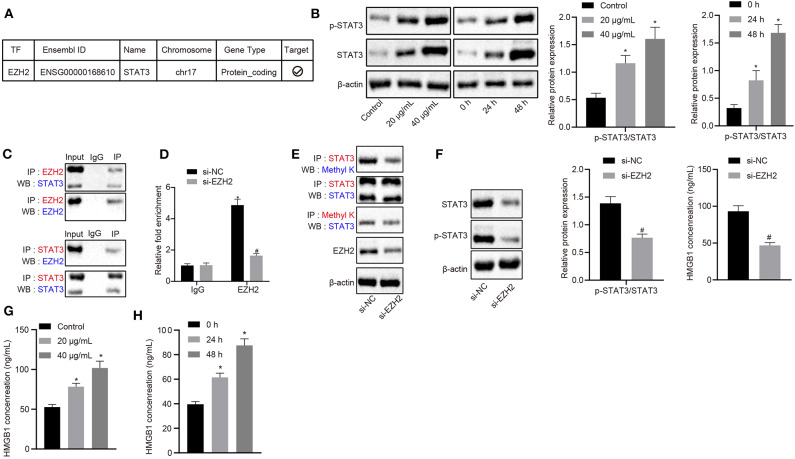
EZH2 methylates STAT3 and activates p-STAT3/HMGB1 in ox-LDL-induced HUVECs. (A) EZH2 could target STAT3 predicted using the web-based bioinformatics resource hTFtarget (http://bioinfo.life.hust.edu.cn/hTFtarget#!/). HUVECs were treated with 0, 20, and 40 μg/ml ox-LDL. (B) Protein levels of p-STAT3/STAT3 in HUVECs at 0, 24, and 48 h measured using Western blot analysis, normalized to β-actin. HUVECs were treated with siRNA targeting EZH2. (C) The interaction between EZH2 and STAT3 in HUVECs detected by IP assay. (D) Enrichment of EZH2 in the STAT3 promoter region in HUVECs detected by ChIP assay. (E) Effect of EZH2 on STAT3 methylation in HUVECs detected by IP assay. (F) Protein levels of p-STAT3/STAT3 in HUVECs measured using Western blot analysis, normalized to β-actin, and HMGB1 concentration determined by ELISA. (G) HMGB1 concentration at 24 h in HUVECs determined using ELISA. HUVECs were treated with 0, 20, and 40 μg/ml ox-LDL for 24 h. (H) HMGB1 concentration in HUVECs determined using ELISA. HUVECs were treated with 20 μg/ml ox-LDL for 0, 24, and 48 h. *(relative to IgG or untreated HUVECs) and #(relative to scramble siRNA-treated HUVECs) indicate p < 0.05 by one-way ANOVA/Tukey's post-hoc test.